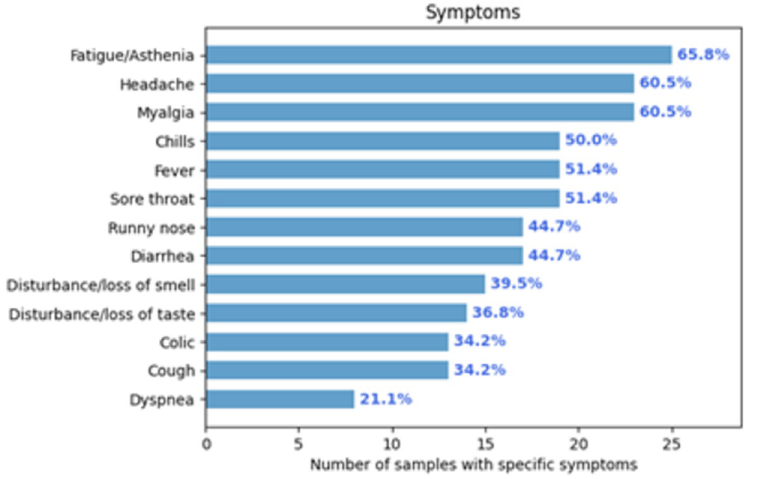
Fig 5. Absolute and relative frequency of samples with a positive diagnosis and specific symptoms.